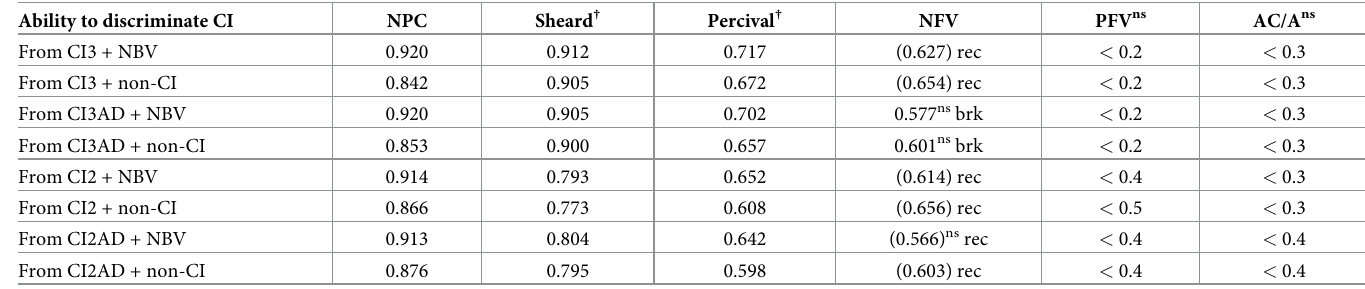
Table 4. Results for the area under the curve (AUC) in ROC curve analysis among CI, non-CI, and NBV groups. Ability to discriminate CI NPC Sheard † Percival † NFV PFV ns AC/A ns From CI3 + NBV 0.920 (0.627) rec < 0.2 < 0.3 From CI3 + non-CI 0.842 < 0.3 From CI3AD + NBV < 0.3 From CI3AD + non-CI < 0.3 From CI2 + NBV From CI2 +